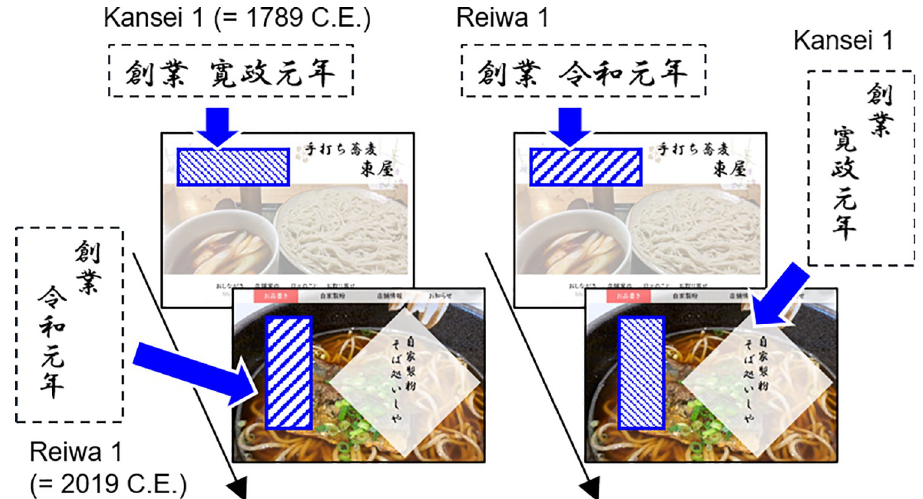
focused and present-focused label conditions were counterbalanced across participants. Food pictures are similar, but not identical, to the original images and are therefore for illustrative purposes only.